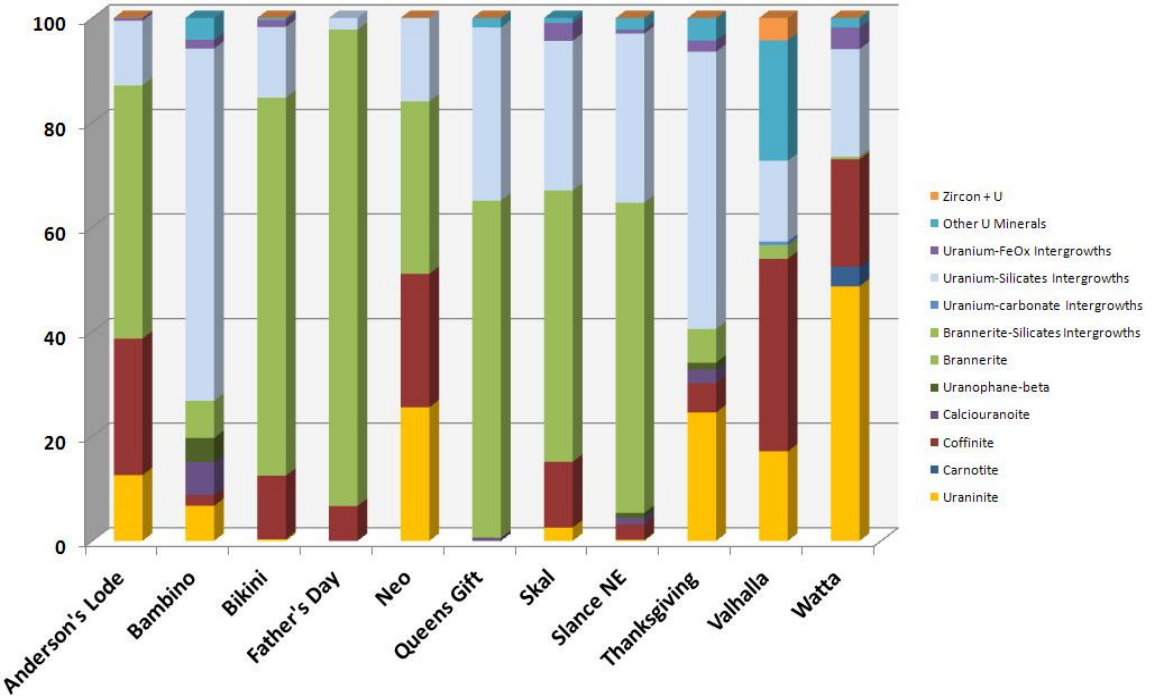
Figure 13. Proportions of uranium minerals in various deposits of the Mount Isa district, as determined by QEMSCAN. Note the major proportion of minerals that could not be reliably identified. There are two end-member mineralogies: uraninite-coffinite ore and brannerite ore. U-Zr minerals seem to be a feature of the Valhalla deposit, but host only a small portion of the uranium.